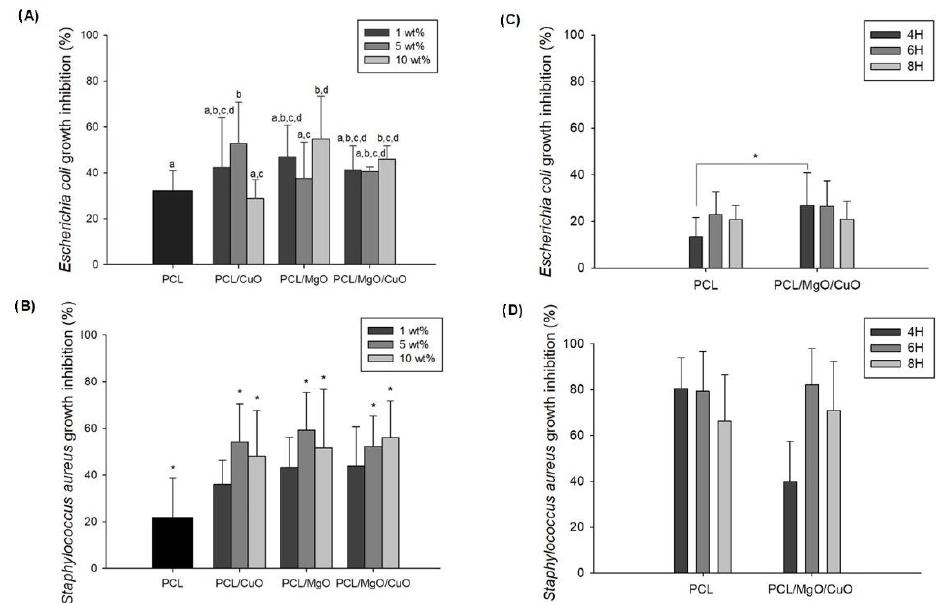
Figure 7. Antibacterial activity of PCL electrospun meshes dopped with different concentrations of CuO NPs (1, 5 and 10 wt%) and MgO NPs (1, 5 and 10 wt%), as well as electrospun meshes with equal incorporation (1:1) of CuO and MgO NPs tested against E. coli ( A ) and S. aureus ( B ), compared with the control condition (PCL electrospun meshes). E. coli ( C ) and S. aureus ( D ) growth inhibition at 4 h, 6 h and 8 h after direct contact with electrospun mesh dopped with the final formulation (5 wt% CuO/10 wt% of MgO NPs) and PCL electrospun mesh as a control. For each assay, the differences between conditions were evaluated all pairwise using Tukey’s test. Bars with the same letters do not have statistically significant differences ( p > 0.05). Statistical significance for p ≤ 0.05